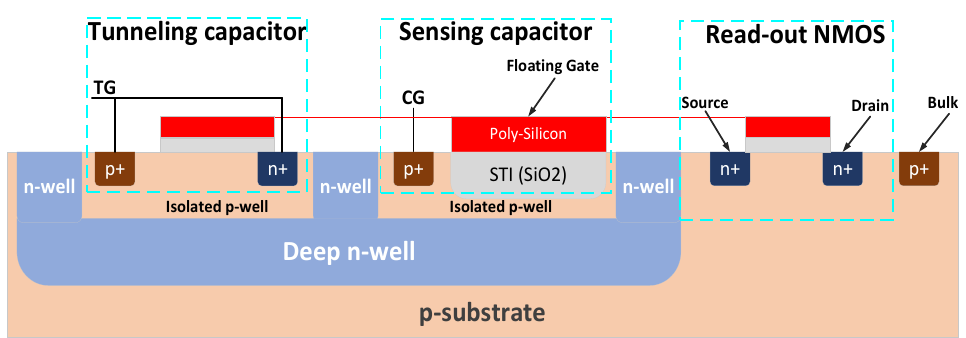
Figure 3. Implementation of C-Sensor in a single-poly CMOS process-schematic cross section.